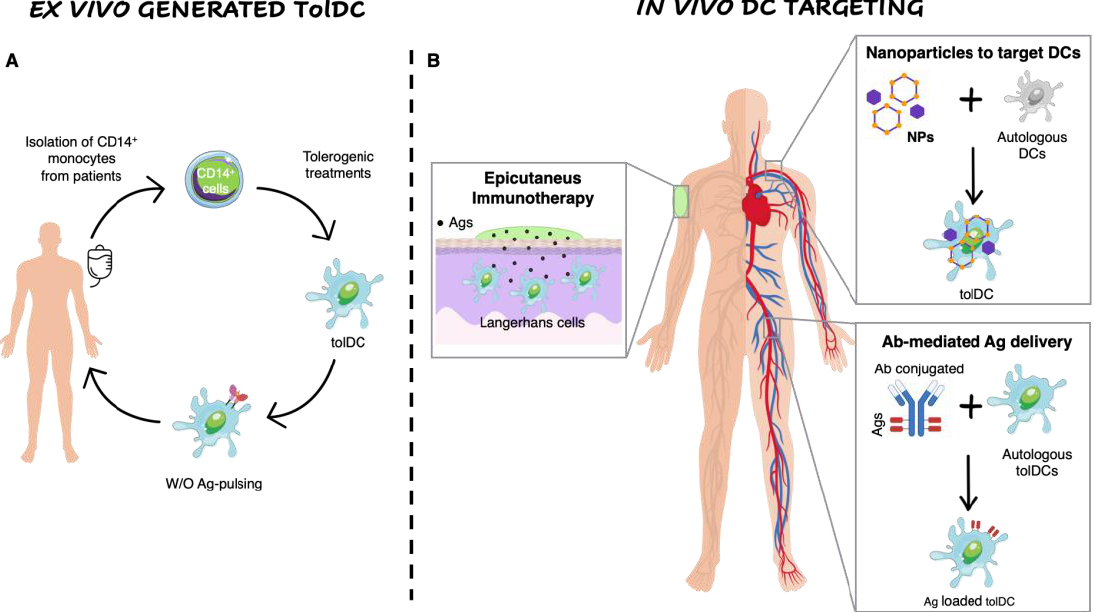
Figure 1. Ex vivo generation of TolDCs vs. in vivo DC targeting. ( A ) Ex vivo generation of TolDCs starts from CD14 + monocyte isolation from peripheral blood of autoimmune disease patients. Monocytes are differentiated into DCs in the presence of tolerogenic agents (i.e., Dexa, VitD3, AS-ODN CD80, CD40, CD86) and then pulsed or not with disease-relevant Ags. The obtained cellular product is infused in patients. ( B ) In vivo targeting of DCs. Nanoparticles encapsulating Ags w/o tolerogenic agents target autologous DCs and skew their phenotype toward a tolerogenic one. Antibodies fused to relevant Ags are generated to recognize surface markers expressed specifically by naturally occurring tolDCs (i.e., DEC205, DCIR2, CLEC9A). Epicutaneous immunotherapy that delivers the Ag to the APCs localized in the superficial layers of the skin .